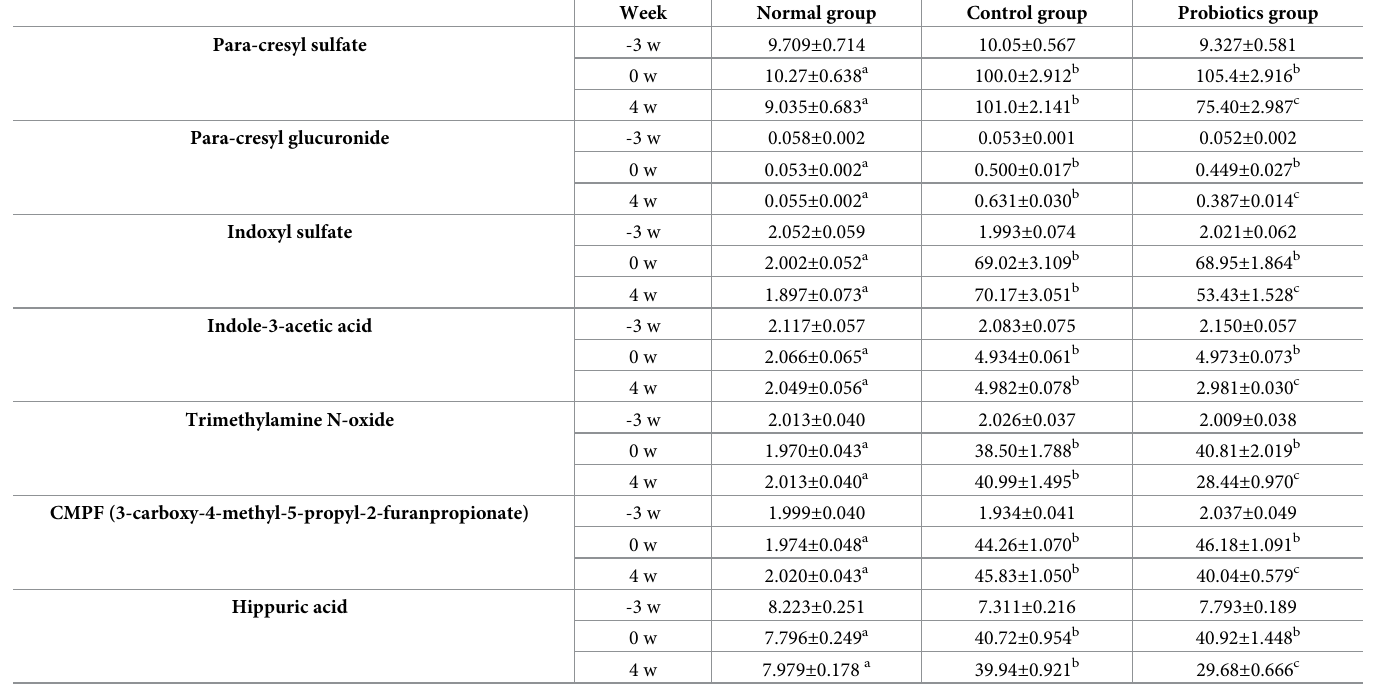
Table 9. The effect of probiotics treatment on serum uremic toxin concentration ( μ M) in adenine-induced CKD